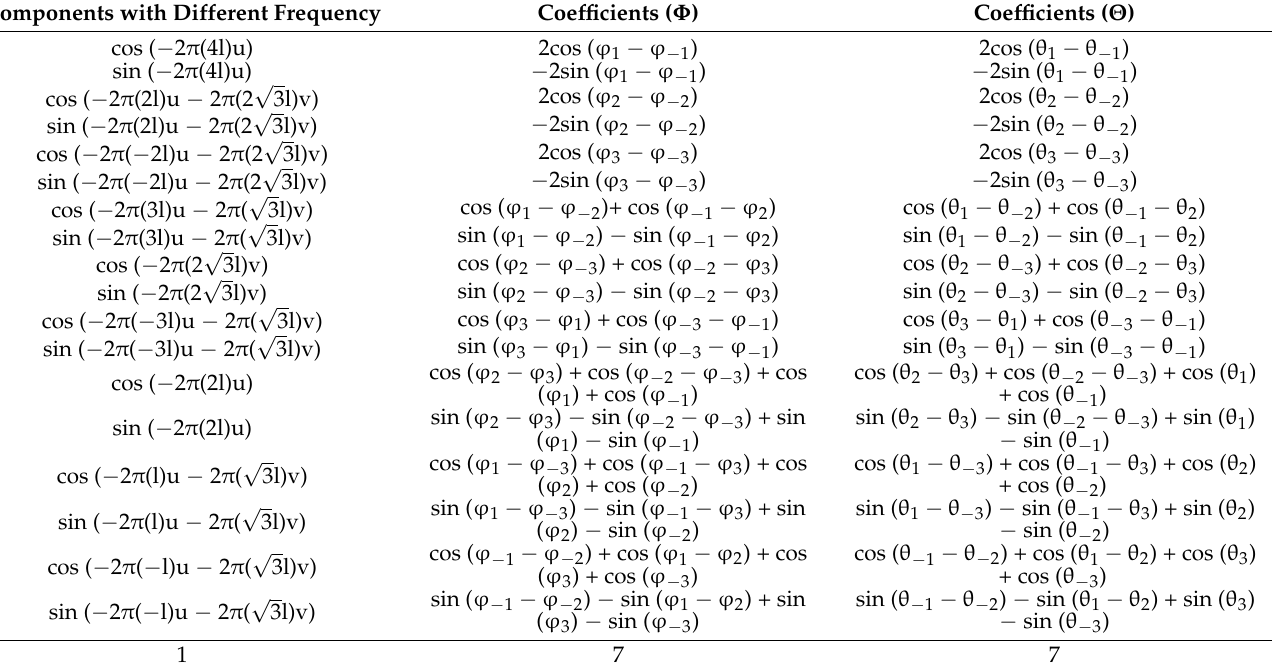
Table A2. Components with different frequency and their coefficients in I (cid:48) far generated by Φ and Θ